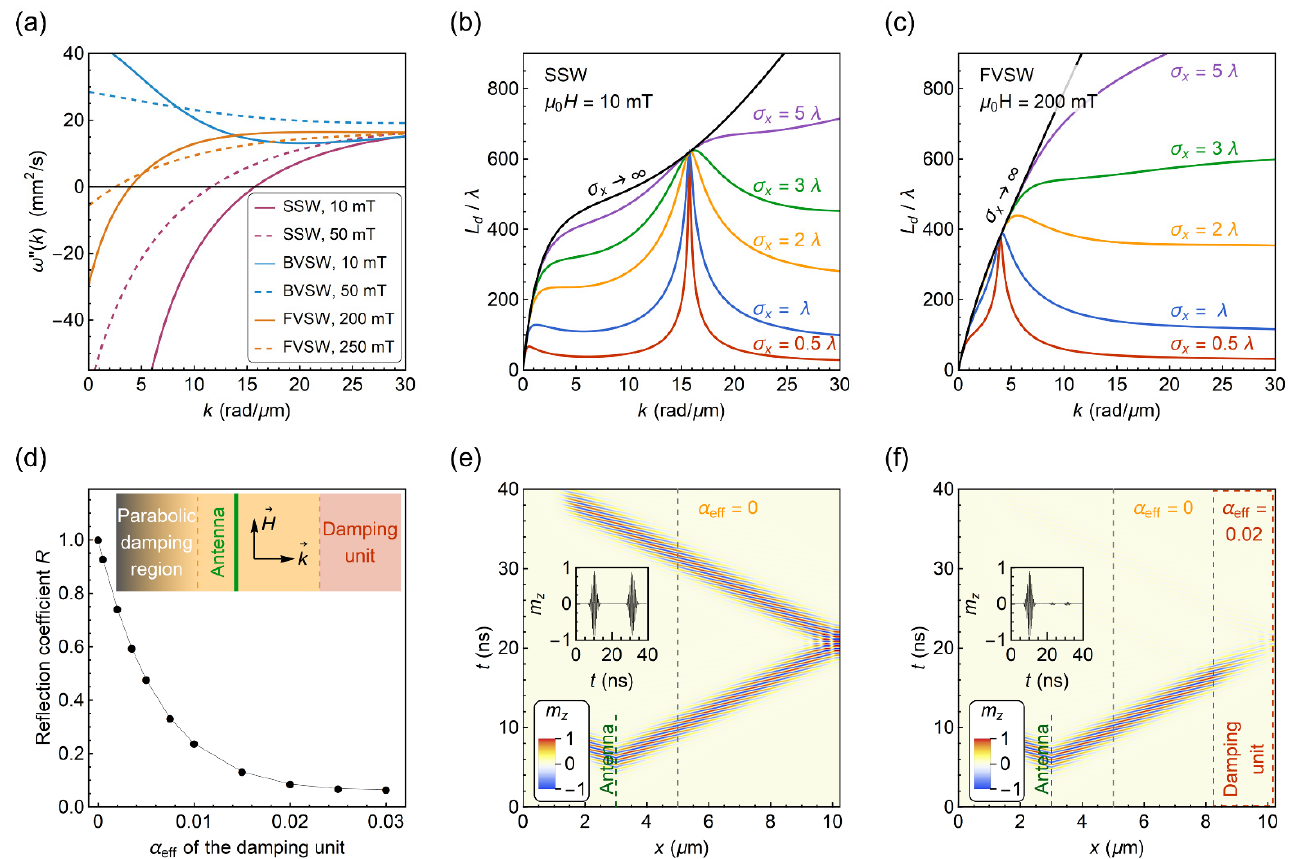
Figure 3. ( a ) Second derivative of the dispersion relation ω (cid:48)(cid:48) ( k ) for the surface and backward volume, and the forward volume SWs. In ( b, c ), the ratio of the decay length L d to the wavelength λ is shown for SSW and FVSW, respectively, for different values of the SW packet spatial width σ x . In figures ( a – c ), the dependencies are calculated for typical parameters of a 50-nm-thick epitaxial YIG film with saturation magnetization M s = 140 kA/m, exchange stiffness D ex = 5.3 · 10 − 17 T · m 2 , and effective damping α eff = 1 · 10 − 4 . ( d ) Reflection coefficient as a function of the effective damping parameter α eff in the damping unit. The inset illustrates the simulation geometry. In ( e , f ), the time evolution of SW packet is shown for a damping unit with α eff = 0 and α eff = 0.02, respectively. The insets show time dependences of the SW amplitude taken at x = 5 µ m (marked with grey dashed lines). Figures ( e , f ) are also visualized in supplementary Videos S1 and S2.